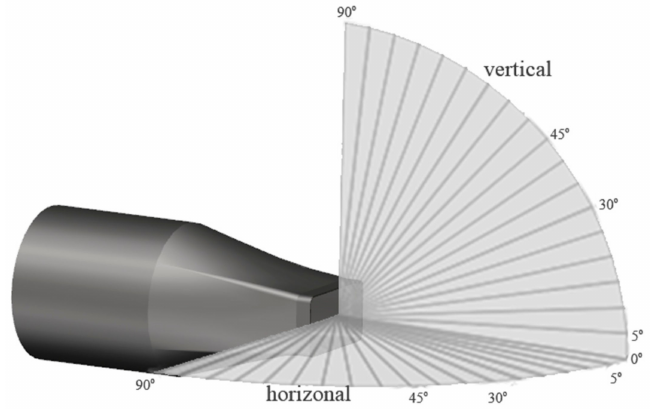
Figure 5. Sketch of the detecting